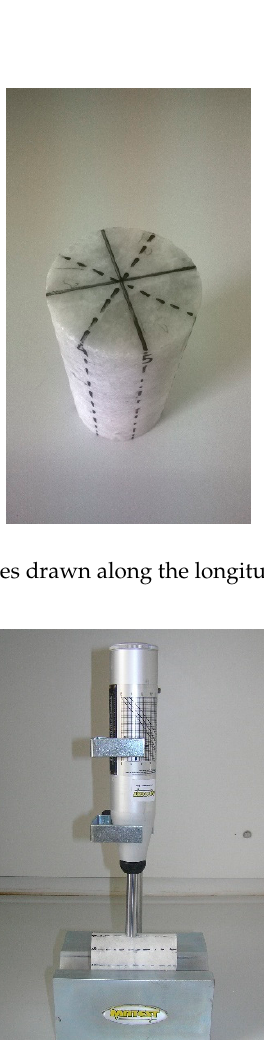
Figure 4. The Schmidt hammer rebound test.